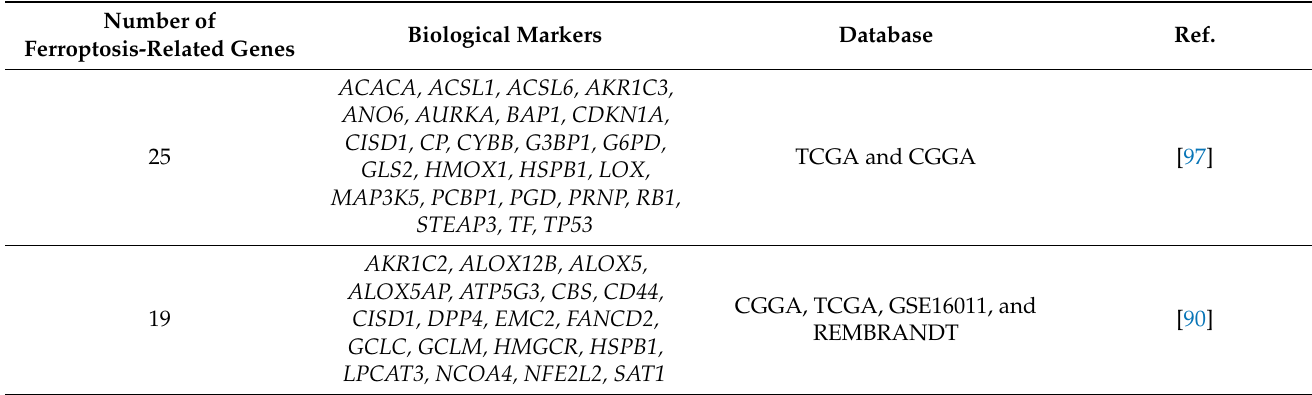
Table 2. The ferroptosis-related genes and lncRNA signature characterized as prognostic indicators for glioblastoma